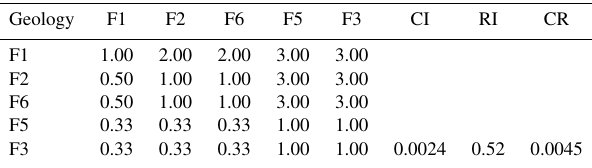
Table 10. Comparison matrix elements for geology